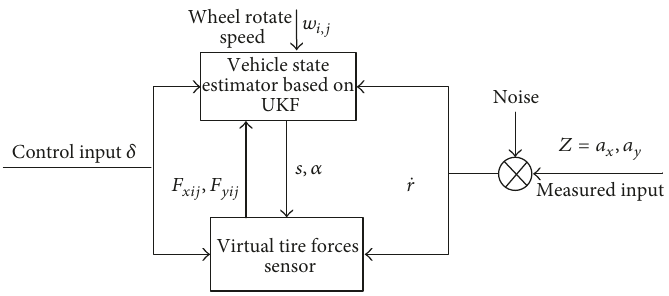
Figure 3: The flowchart of the sideslip angle estimator.